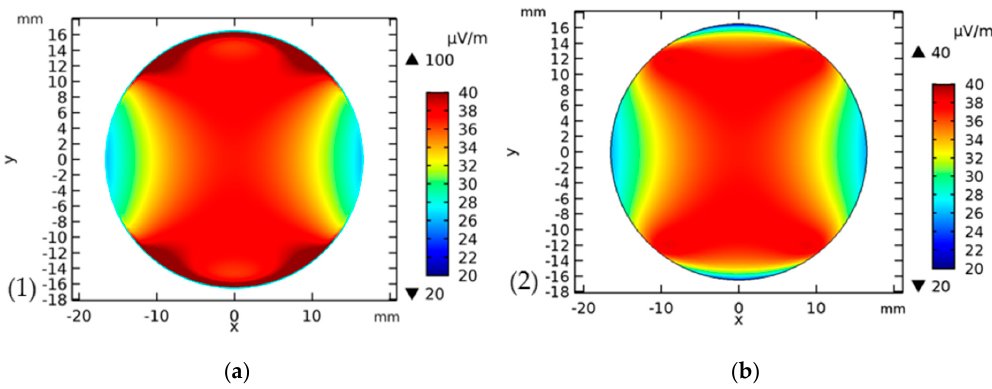
Figure 2. Numerical simulation of electric fields within the experimental test setup. ( a ) The electric field distribution simulated with COMSOL Multiphysics ® , v5.3a at the bottom of the Petri dish and ( b ) at 1 mm above the bottom for a potential difference of 1 V. At an amplitude of 141.4 mV, the result has to be scaled by a factor of 0.1414, yielding e.g., a maximum field of about 5.7 µV/m instead of 40 µV/m at 1 V amplitude.